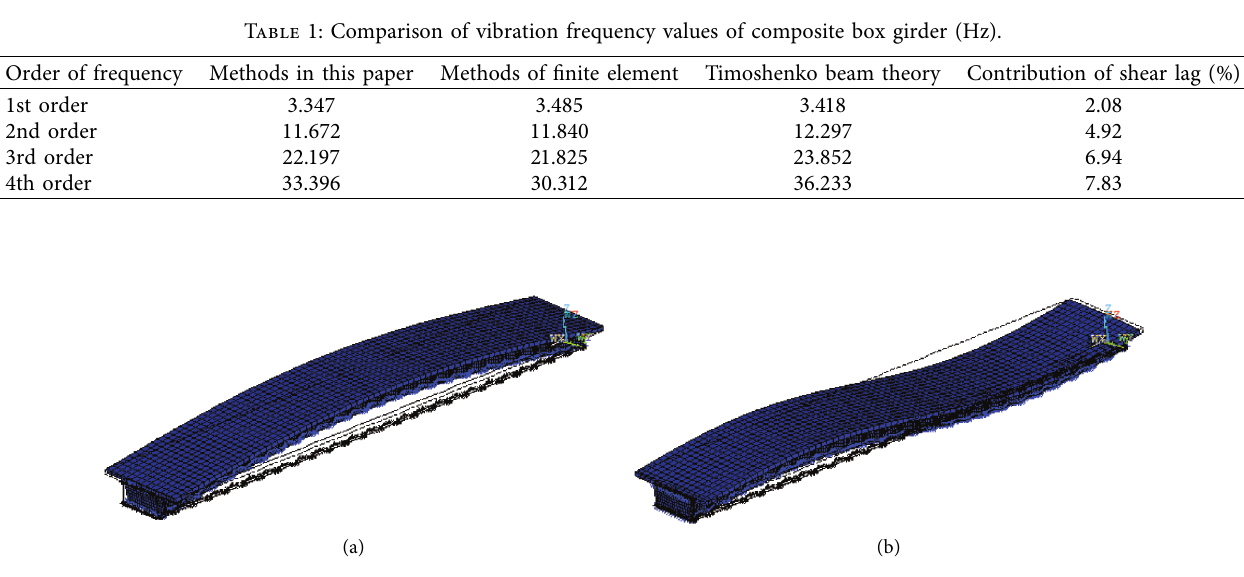
Figure 5: Structural vibration mode. Finite element analysis of (a) first-order mode and (b) second-order mode. Table 2: Comparison of vibration frequency values of composite box girder with different high span ratios